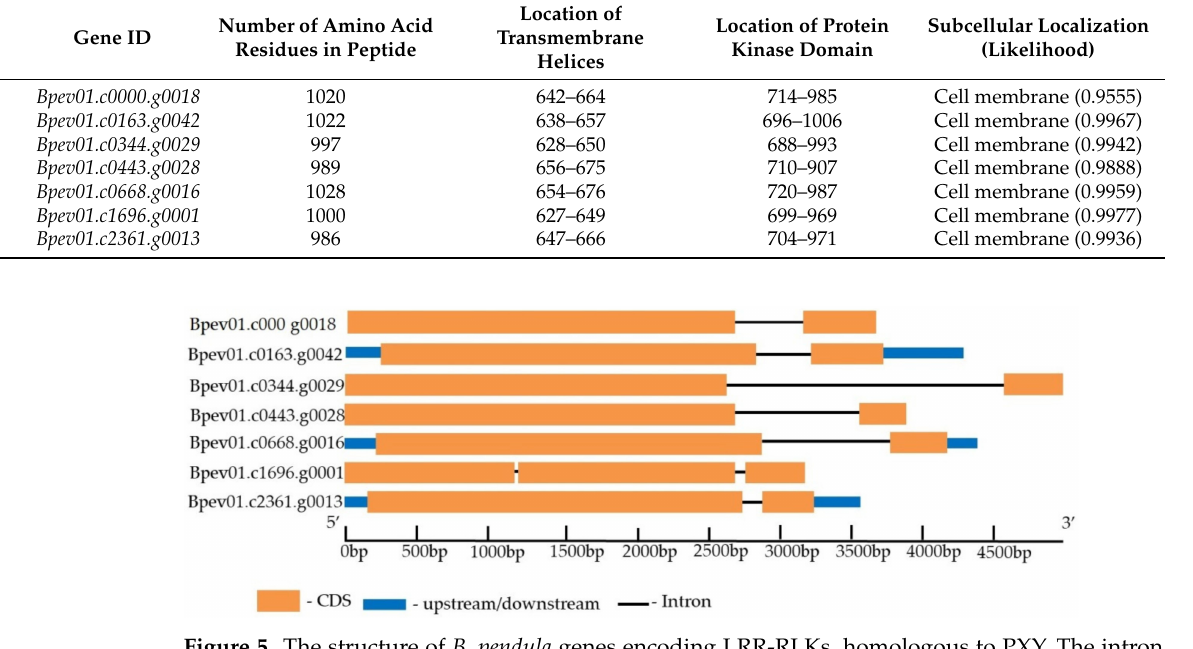
Figure 5. The structure of B. pendula genes encoding LRR-RLKs, homologous to PXY. The intron, exon, and untranslated region (UTR) are represented by black lines, orange boxes, and blue boxes, respectively.